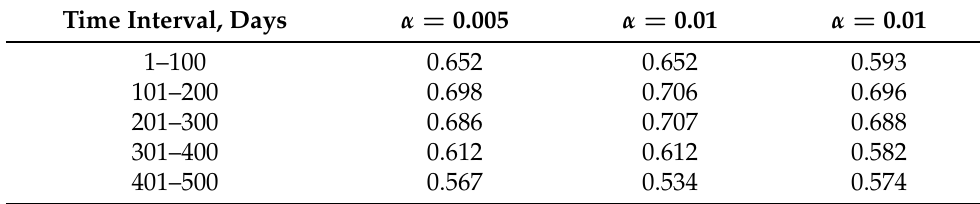
Table 4. Positive outcome frequency: opening and closing by smoothed